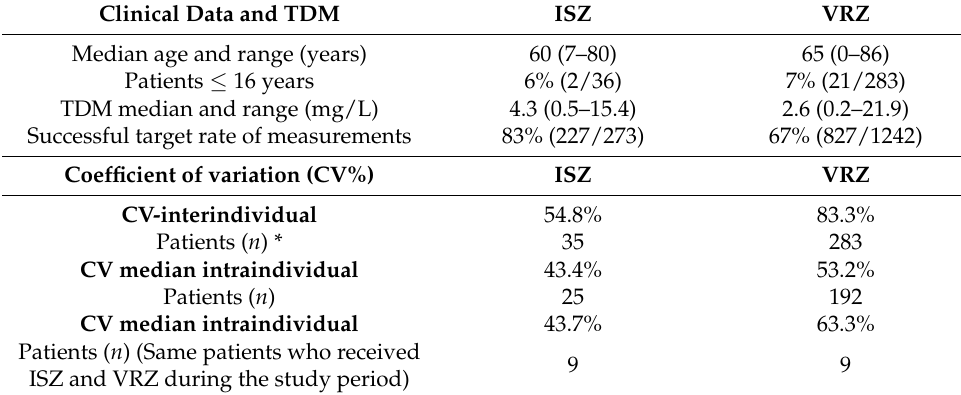
Table 3. Comparison of ISZ and VRZ. Clinical data and coefficient of